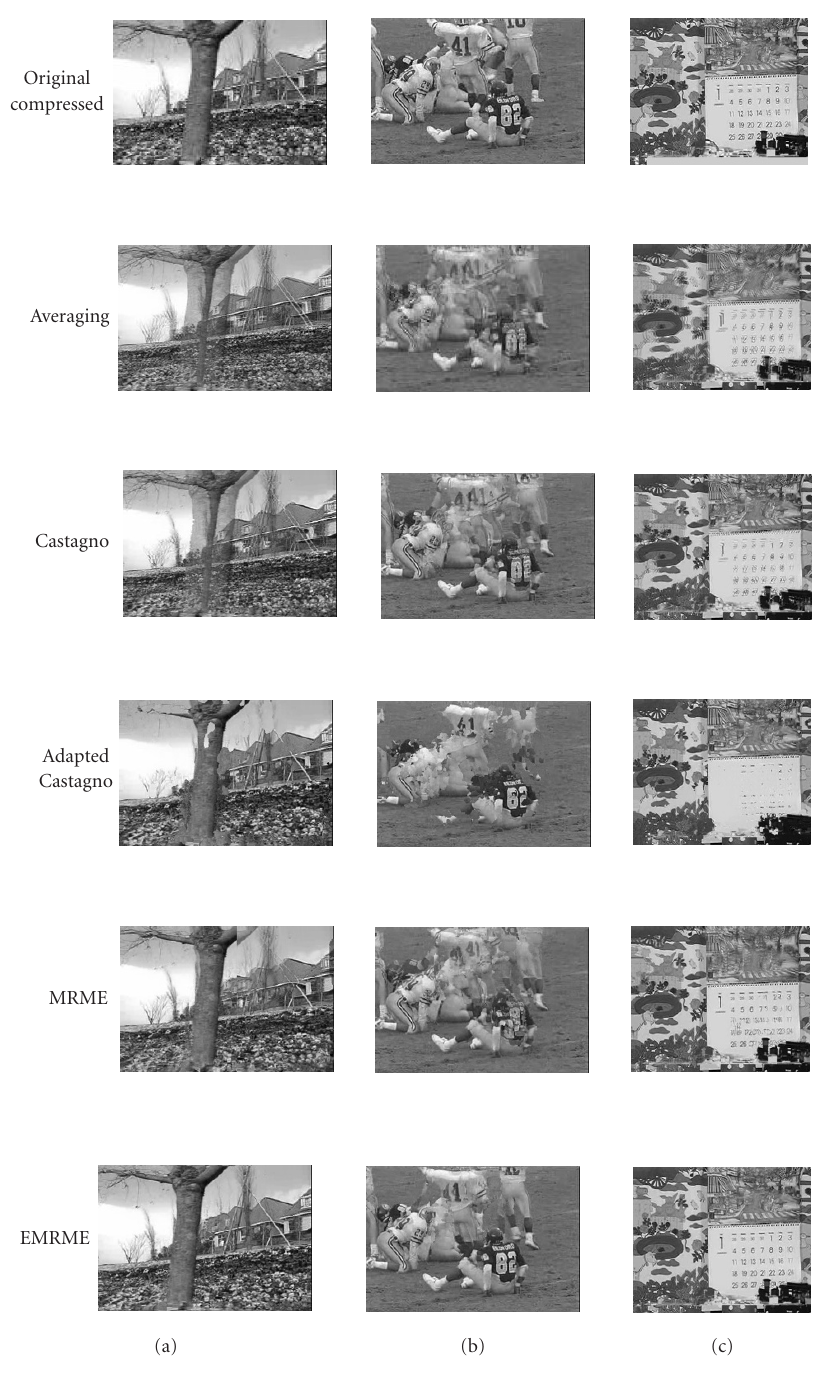
Figure 5: Typical results for interpolation on SIF and CIF image sequences. (a) Flower Garden. (b) Football. (c) Mobile & Calender.